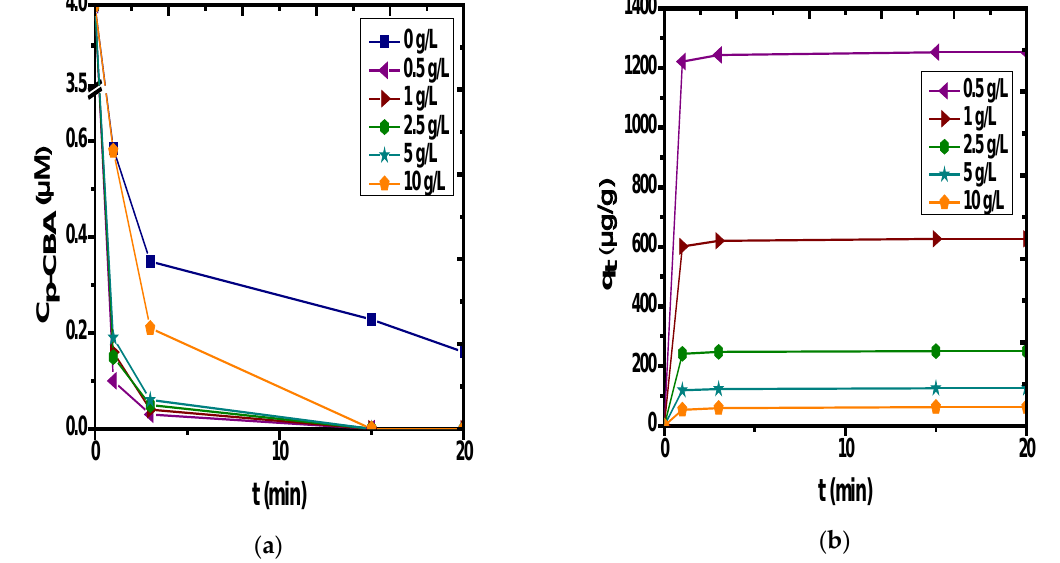
Figure 7. Influence of PET dosage on removal of p-CBA during the heterogeneous catalytic ozonation; ( a ) Removal of p-CBA ( µ M), ( b ) Removal of p-CBA expressed as µ g/g catalyst; experimental conditions: C O = 2 mg/L, C p-CBA = 4 µ M, pH = 7, T = 20 ◦ 3